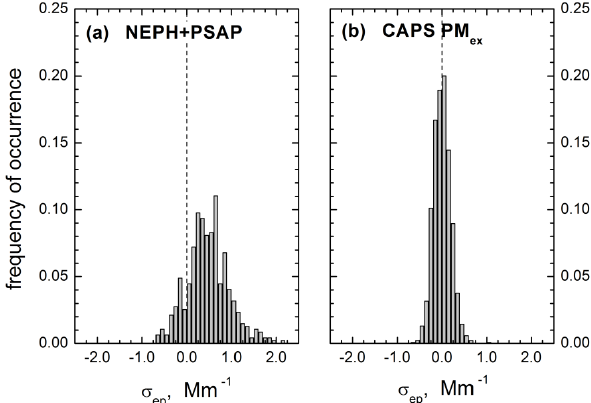
Figure 8. Histograms of the electronic noise of NEPH+PSAP (left panel) and CAPS PM ex Fig. 8. Histograms of the electronic noise of NEPH + PSAP (left panel) and CAPS PM ex (right panel) averaged for > 1h of sampling (right panel) averaged for > 1 hour of sampling particle-free air. particle-free